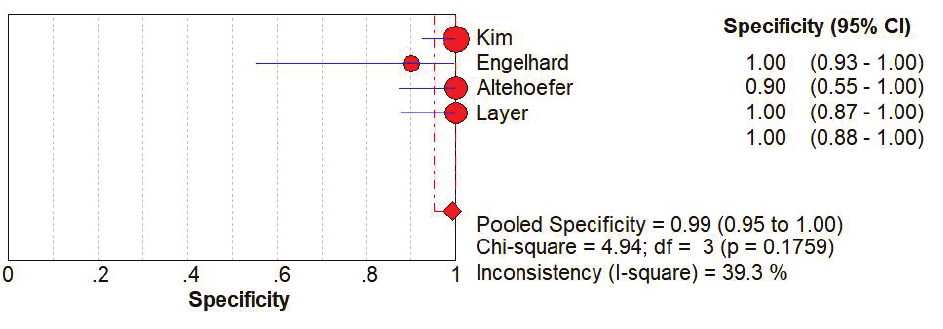
Figure 4: The plot for the sensitivity of curve. The area under the SROC curve (AUC) is 0.9948 and the Q* is 0.9720 (Figure 8).